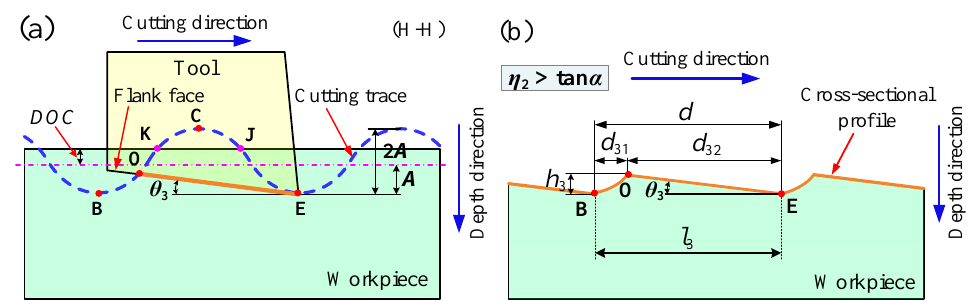
Figure 7. The flank face intersects with the BK segment of cutting trace on point O ( η 2 > tan α ): ( a ) cutting trace; ( b ) cross-sectional profile of dimples.